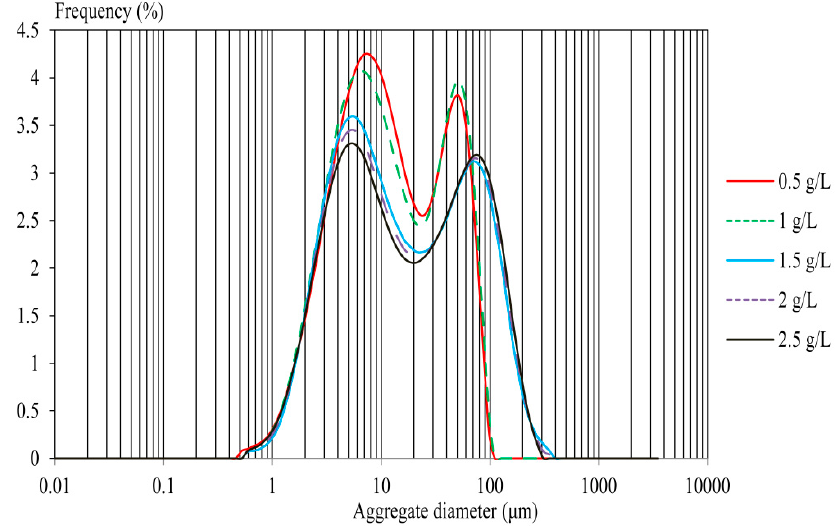
Figure 3. Particle diameter distribution of different concentrations of NZVI suspension. The horizontal axis represented iron aggregate diameter, and the vertical axis was the frequency of aggregate of different size.